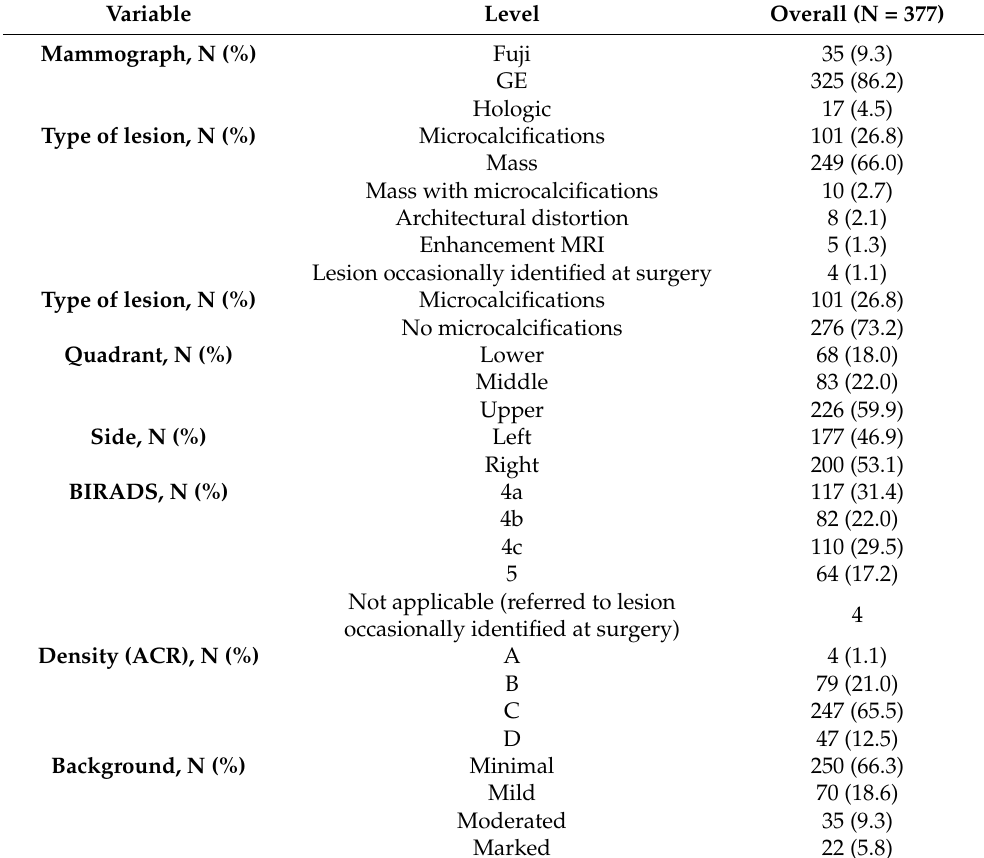
Table 1. Descriptive variables at breast lesion level (N =